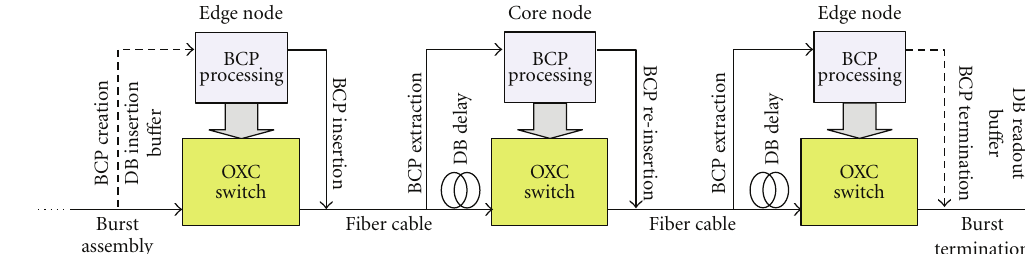
Figure 12: OBS network with fixed delay lines in data channels at node sites.